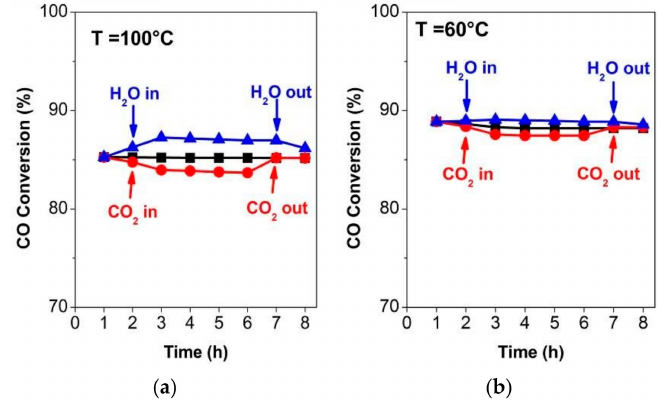
Figure 8. CO conversion versus time of stream over the AuAg / CeO 2 catalyst under diverse conditions: gas mixture (black line), water addition (blue line) and carbon dioxide addition (red line). ( a ) Reaction temperature of 100 ◦ C, and ( b ) reaction temperature of 60 ◦